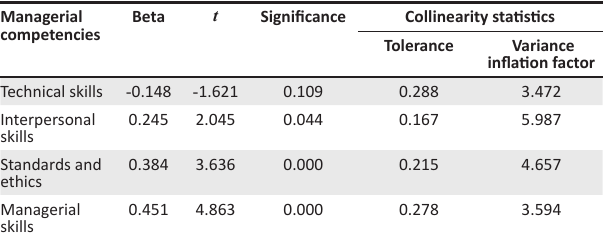
TABLE 8: Regression analysis: Managerial competencies and job